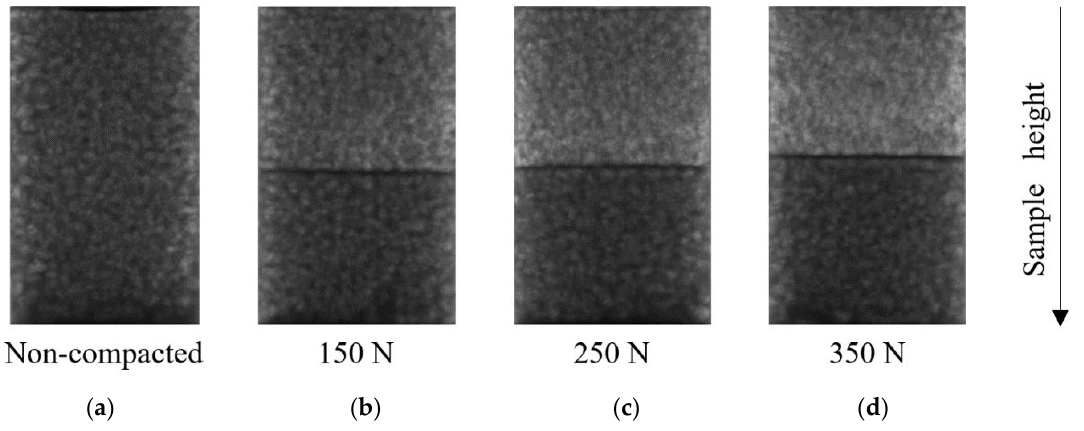
Figure 2. X-ray imaging of selected samples: ( a ) non-compacted, ( b ) 150N, ( c ) 250 N, and ( d ) 350 N.